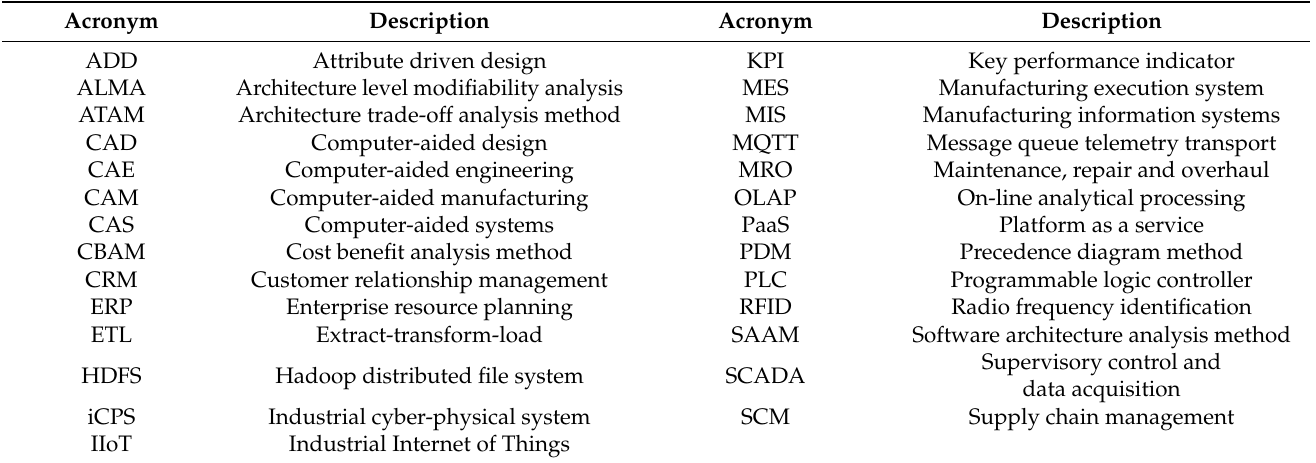
Table 1. List of acronyms and their